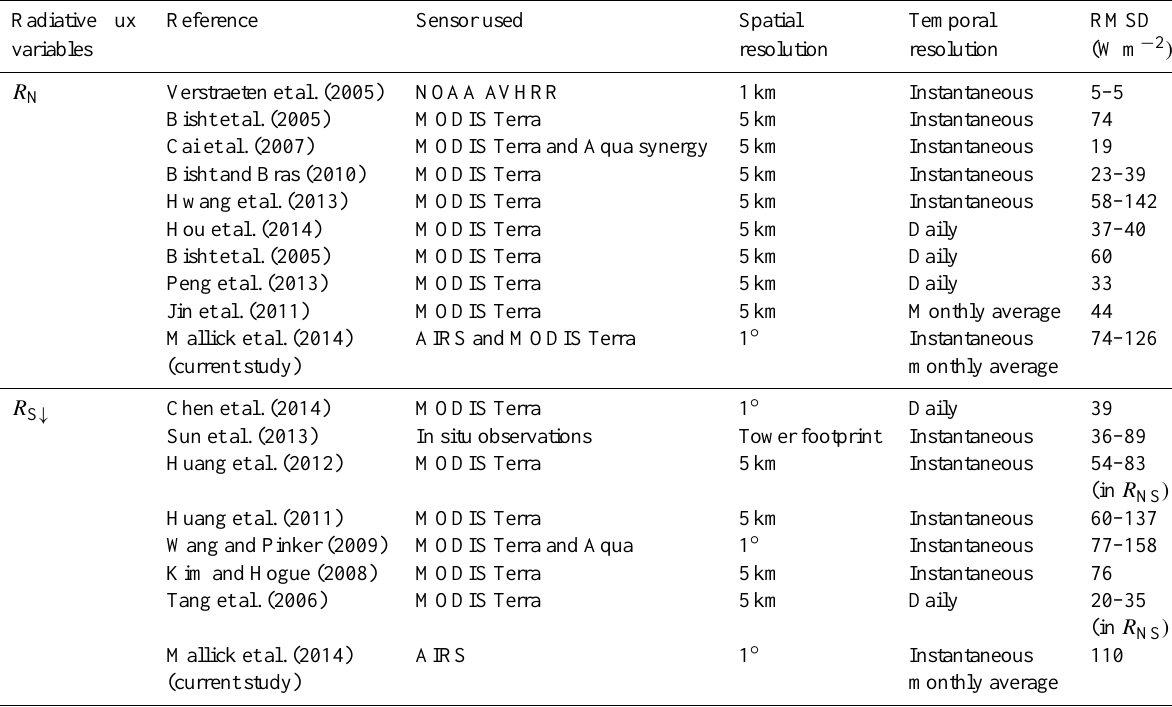
Table 4. Summary of errors and characteristics of some of the dedicated satellite-based R N and R S ↓ retrieval studies. Radiative